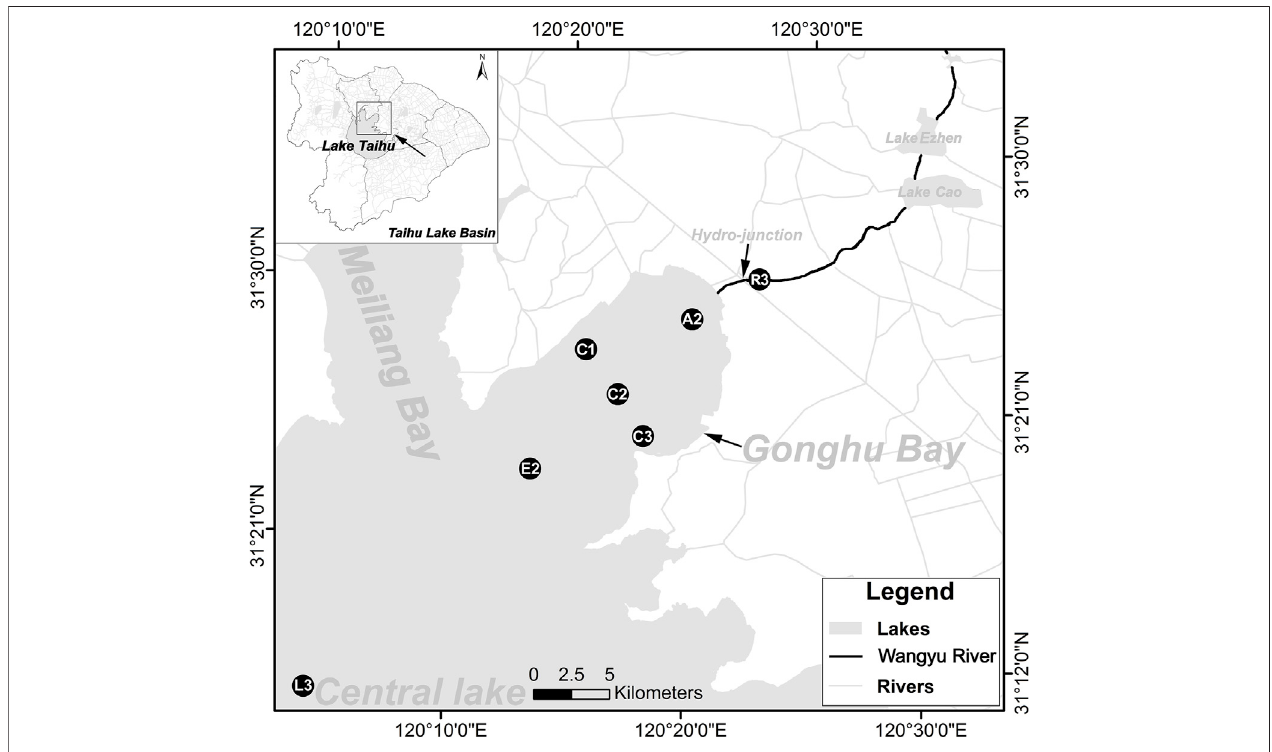
FIGURE 8 | The most cost-effective sites distribution in Wangyu River, Gonghu Bay, and the lake center of Lake Taihu.